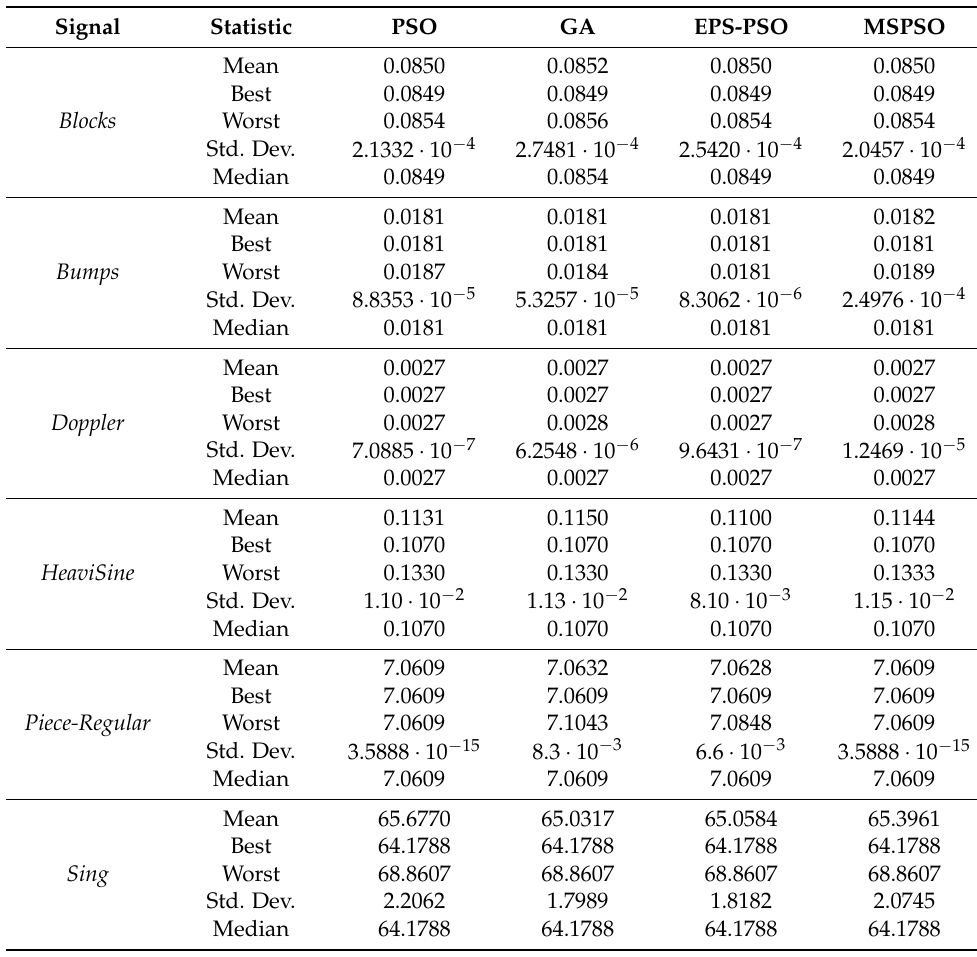
Table 45. The computational results obtained by the PSO-based and GA-based optimization algo- rithms after 50 iterations, averaged over 50 independent